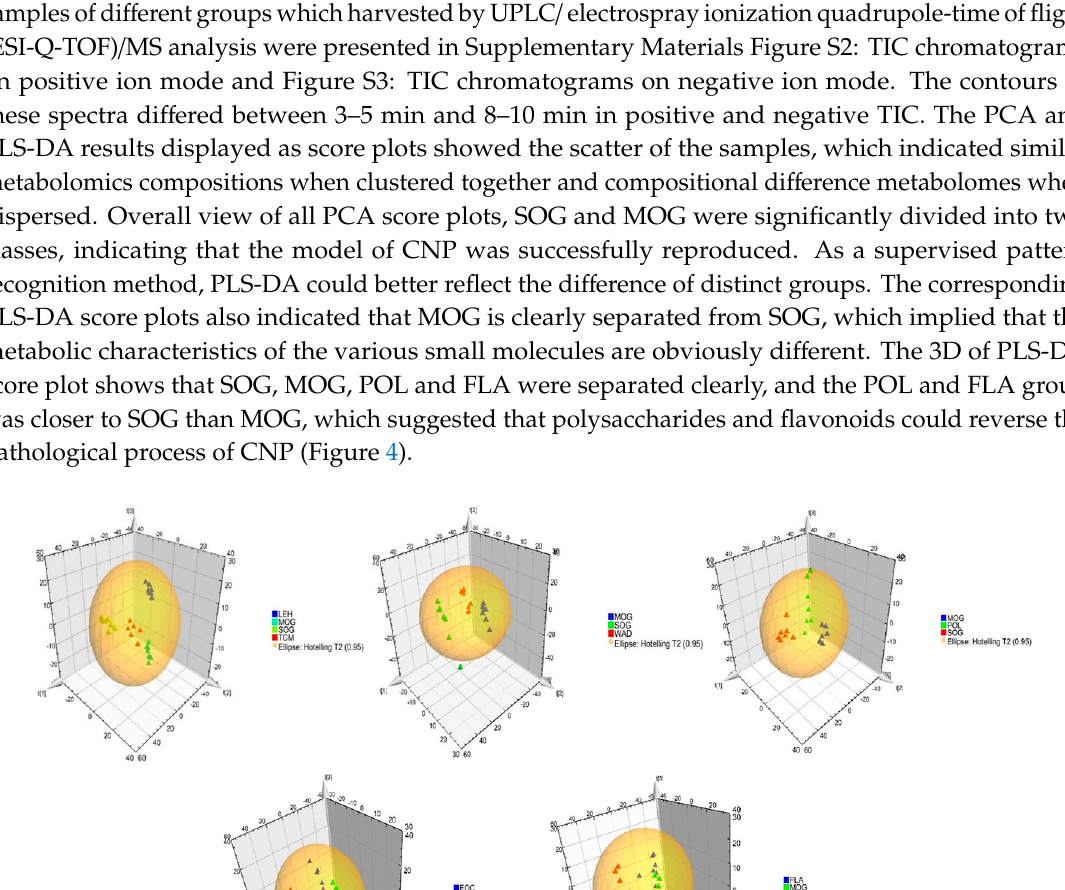
Figure 3. Changes of VO 2 , VCO 2 , H, EE and RER in rats during the day, night and the whole day.